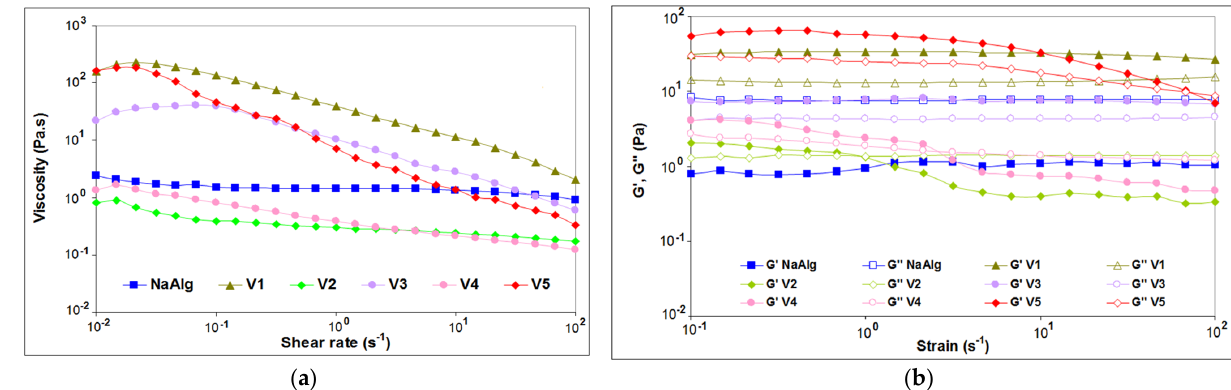
Figure 3. Rheological characterization: ( a ) viscosity as a function of shear rate for prepared alginate ‐ based hydrogels at different pH and 37 °C and ( b ) dependence of G’ and G” moduli on the ampli ‐ tude strain at 37 °C for the alginate ‐ based hydrogels at different pH .